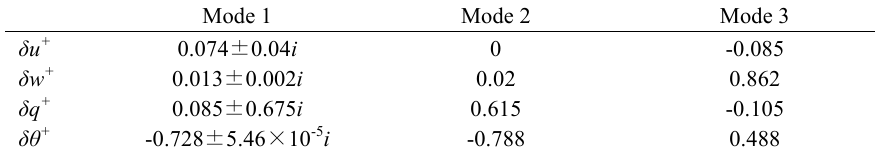
Table 3 Eigenvectors of the system